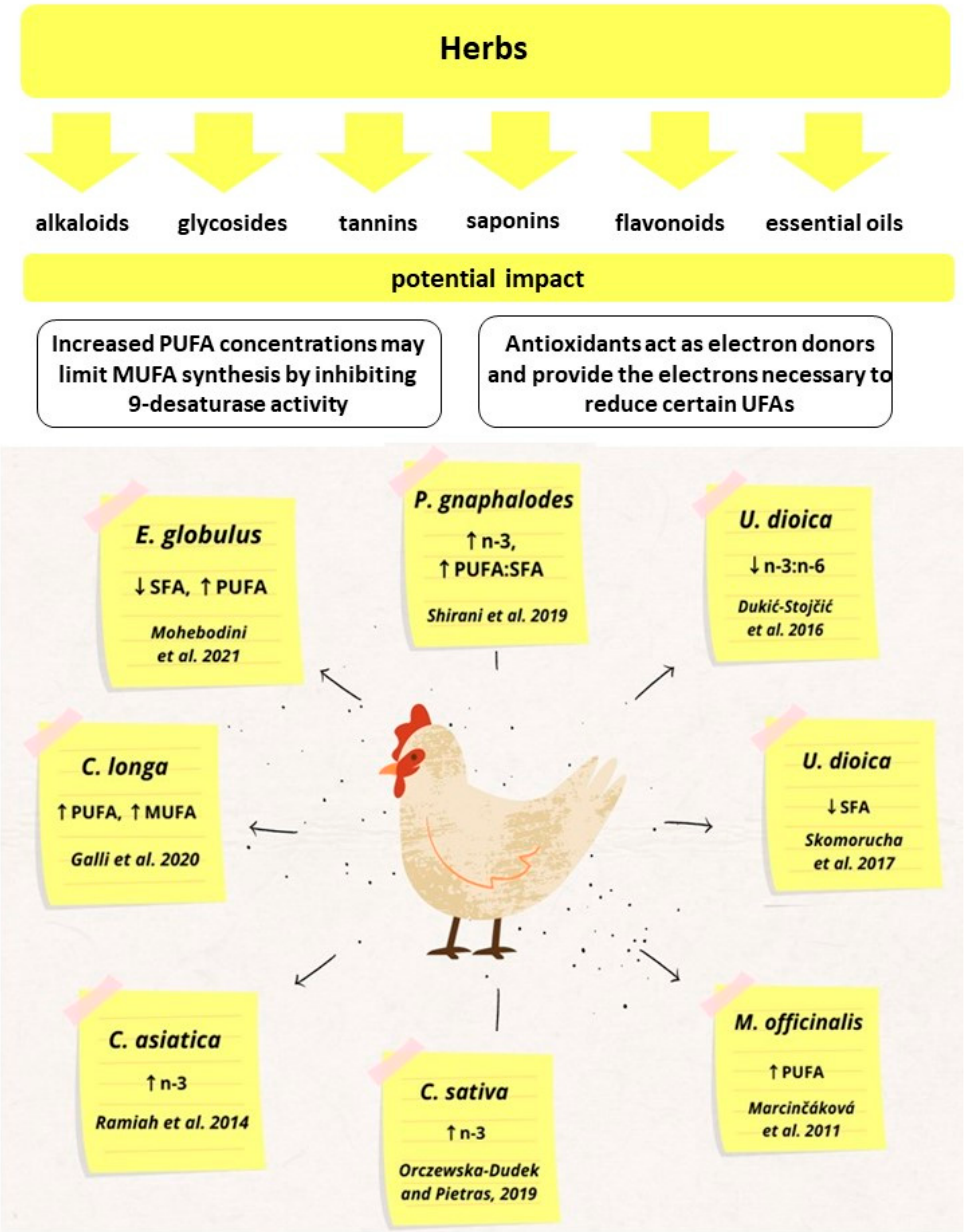
Figure 1. The positive effects of herbal additives on broiler chicken feed.